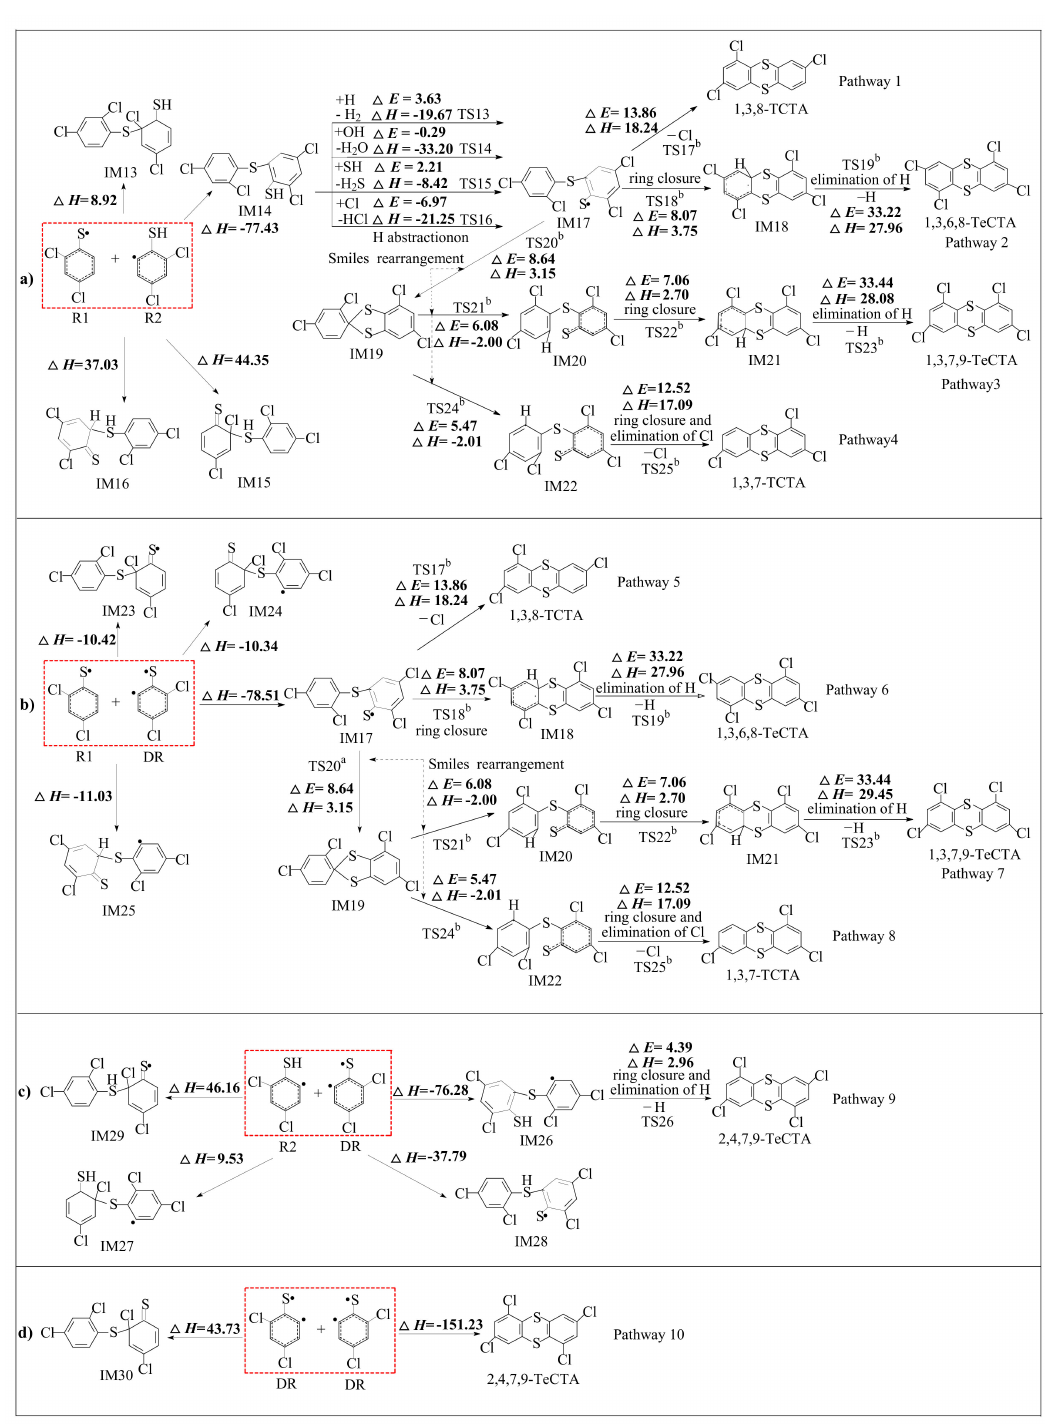
Figure 3. Polychlorinated thianthrene (PCTA) formation routes embedded with the potential barriers ∆ E (in kcal / mol) and reaction heats ∆ H (in kcal / mol) from self- and cross-couplings of R1 + R2 ( a ), R1 + DR ( b ), R2 + DR ( c ), and DR + DR ( d ). ∆ H is calculated at 0 K. ( b Reproduced with permission from Xu et al.